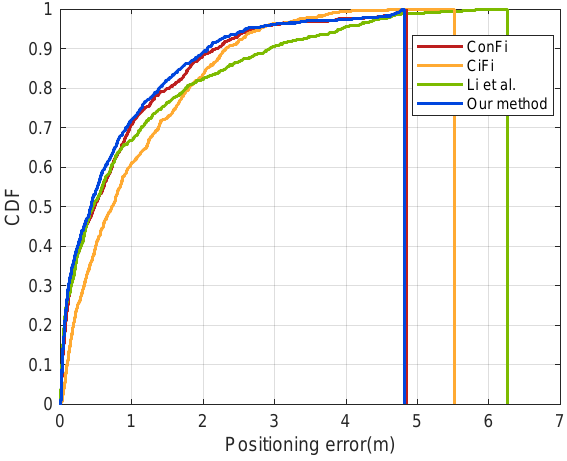
Figure 10. The CDF of positioning errors for different CSI extraction methods [18,21,22].